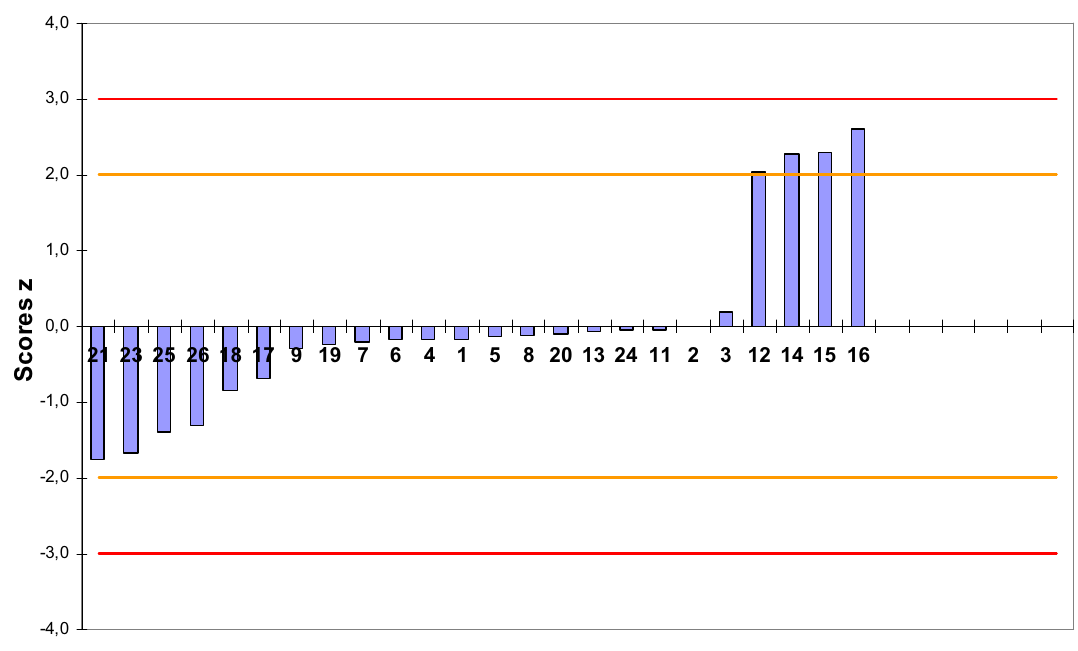
Fig. 5. (Color online) Z -scores obtained by the laboratories for the histamine amount in the level 2 PTS sample.